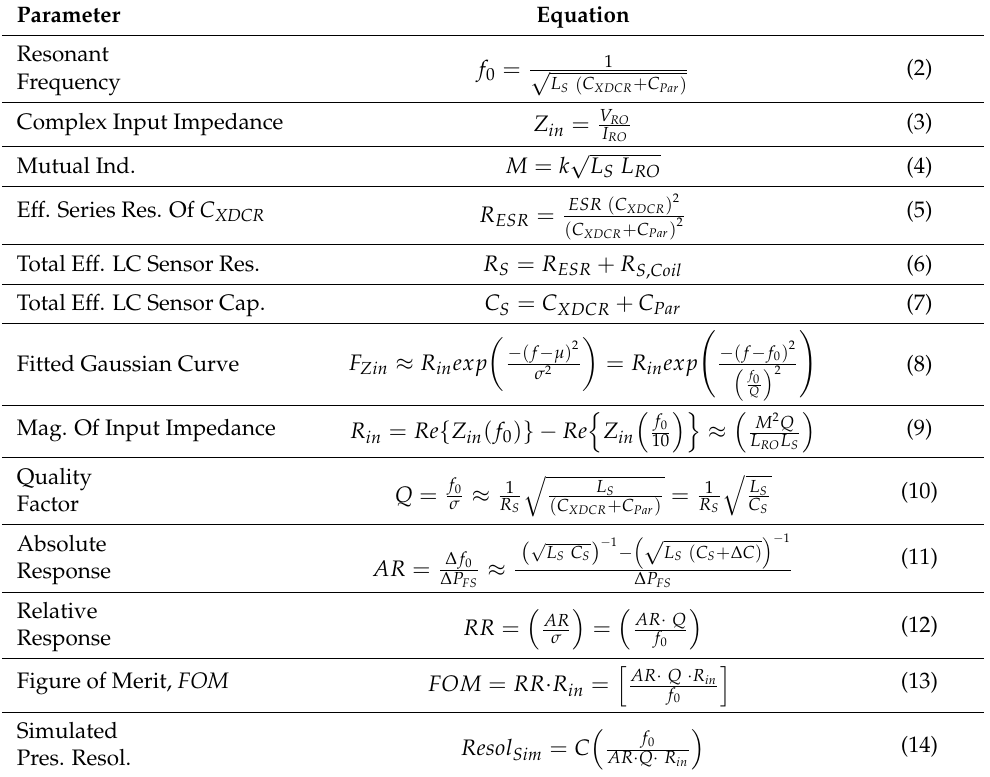
Table 1. Inductor-Capacitor (LC) Sensor Design